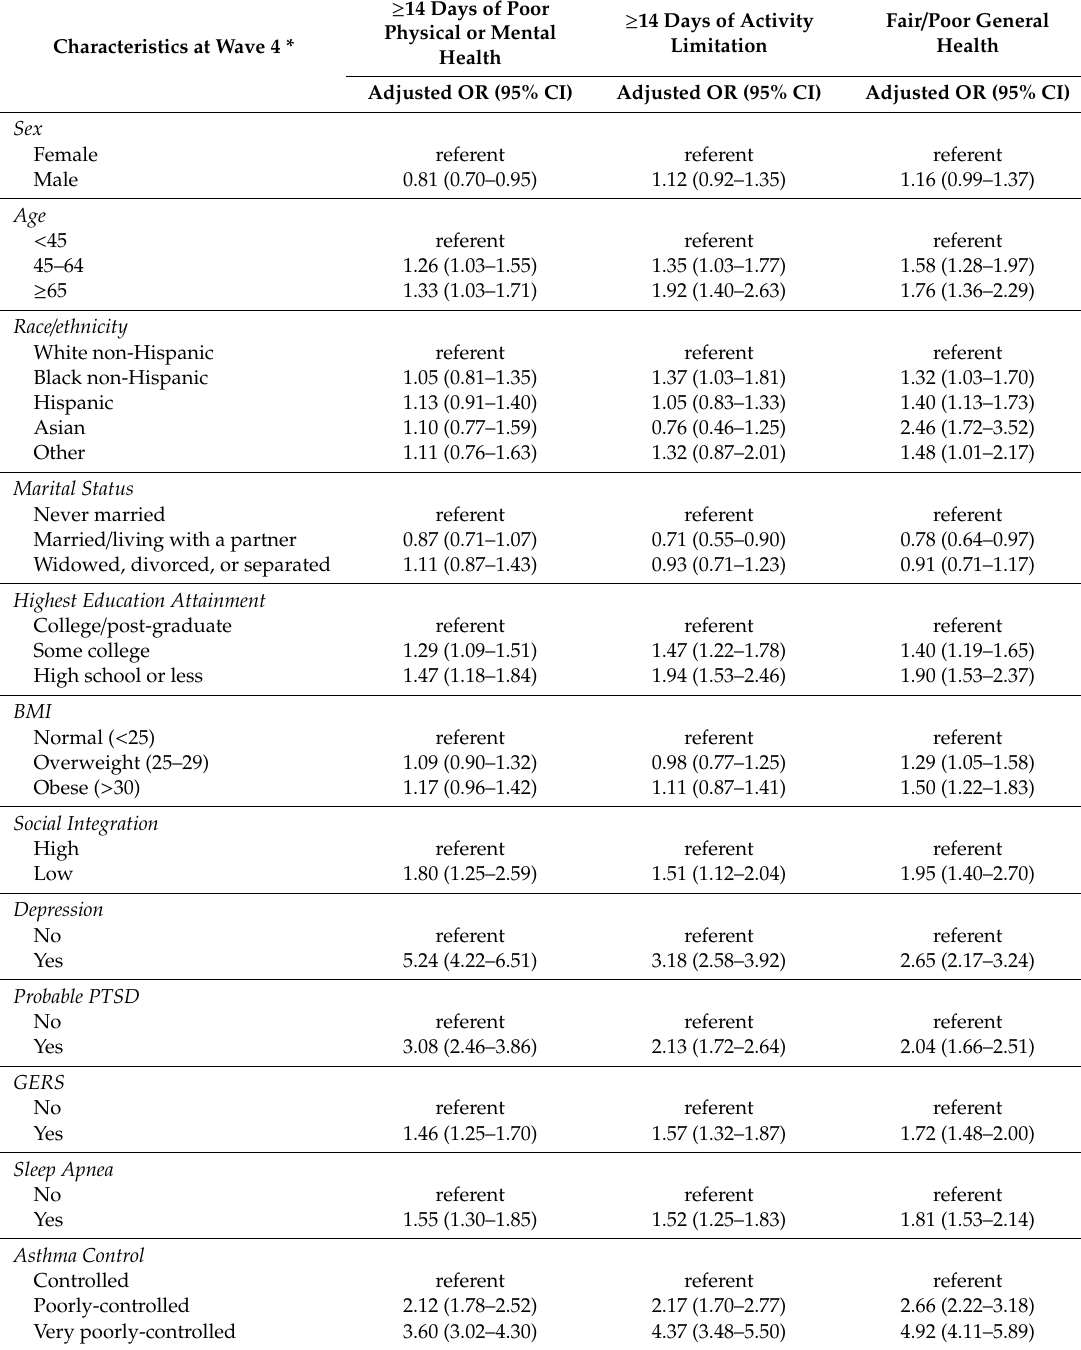
Table 3. Multivariable odds ratios for association of three health-related quality of life indicators with asthma control, controlling for selected sociodemographic factors, WTC dust cloud exposure, physical and mental health co-morbidities among 9 / 11-exposed individuals with asthma, 2015–2016.